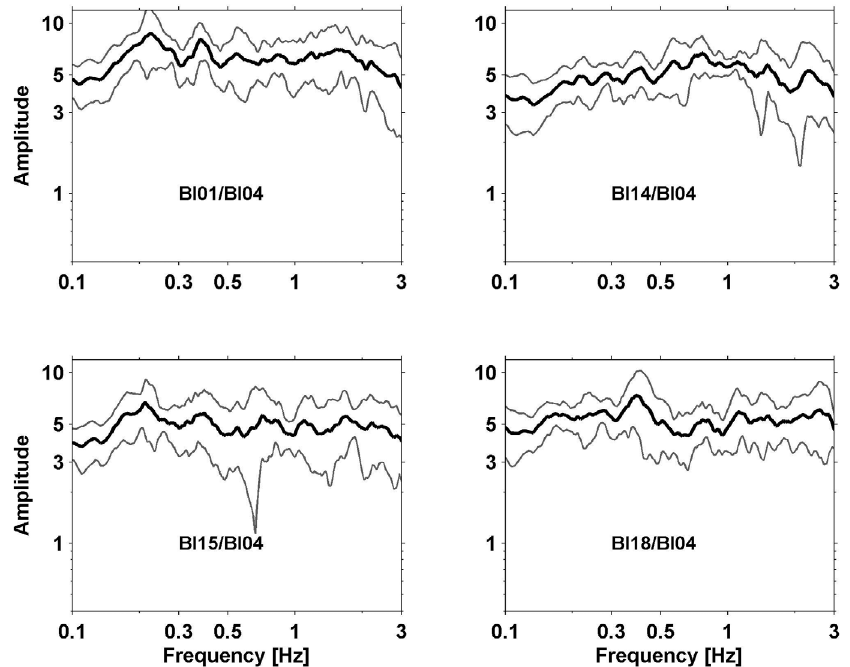
Figure 6. Acceleration response spectrum ratio of each station w.r.t BI04. The gray lines represent the plus/minus one standard deviation.